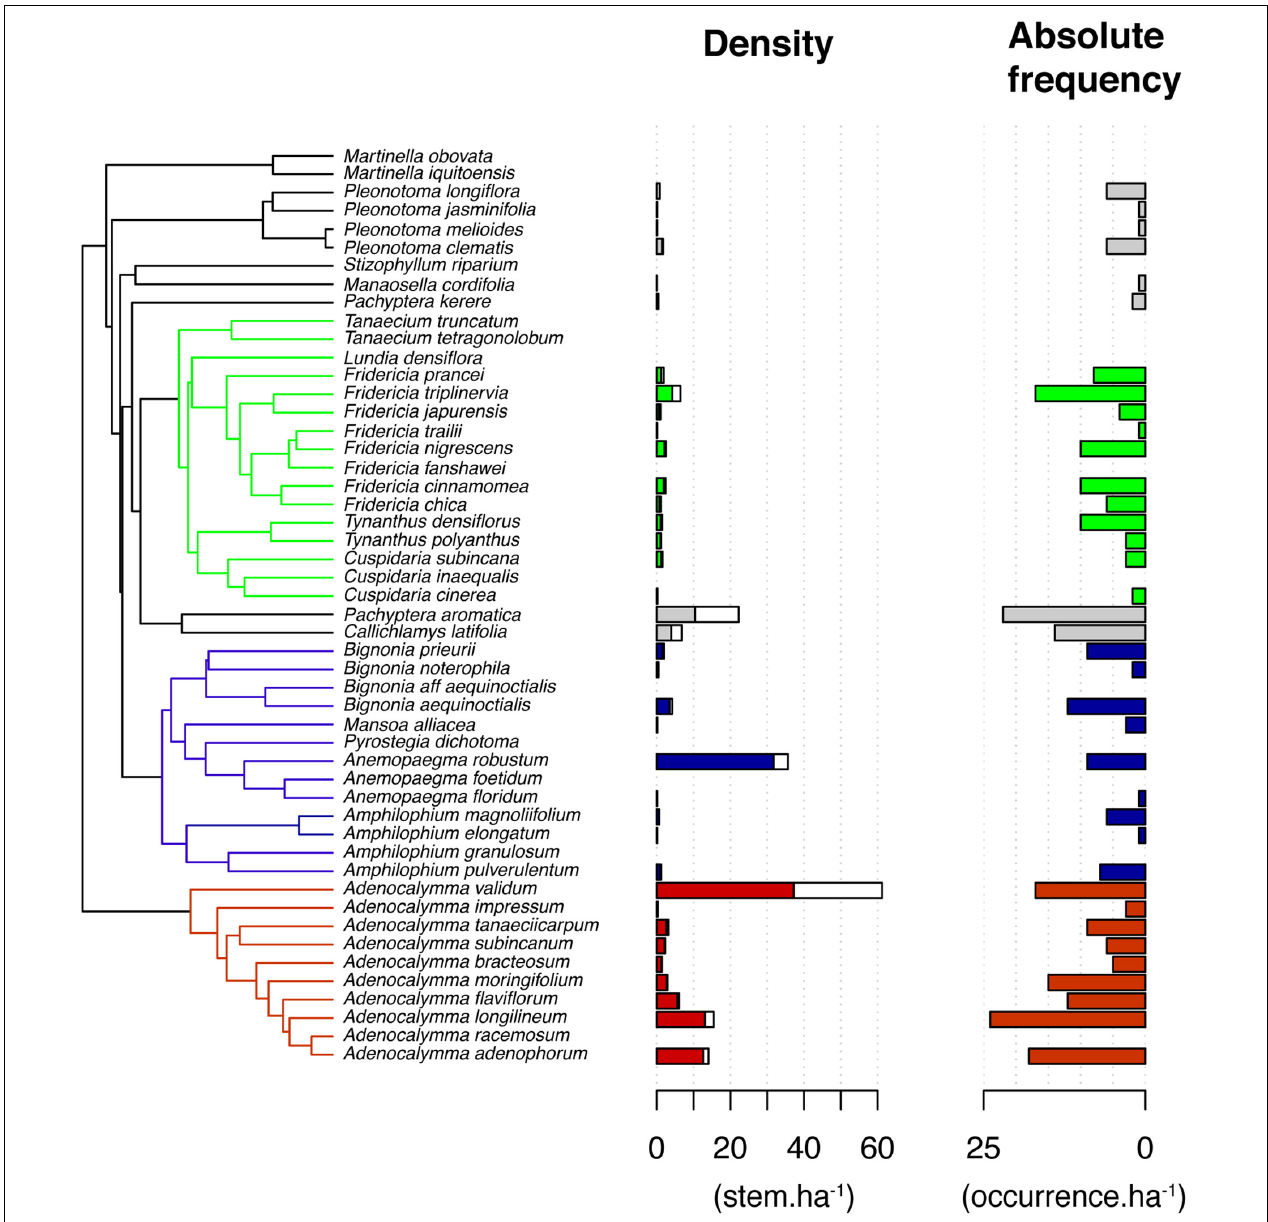
FIGURE 1 | Phylogenetic relationships among the 38 liana species of the tribe Bignonieae (Bignoniaceae) and their stem density (genets in filled bar and ramets in the hollow bar) and absolute frequency in plots sampled at Ducke Reserve (Central Amazon, Brazil). Red, blue, and green highlight the three main clades of the tribe Bignonieae: Adenocalymma , Multiples-of-Four, and Fridericia-and-Allies, respectively.